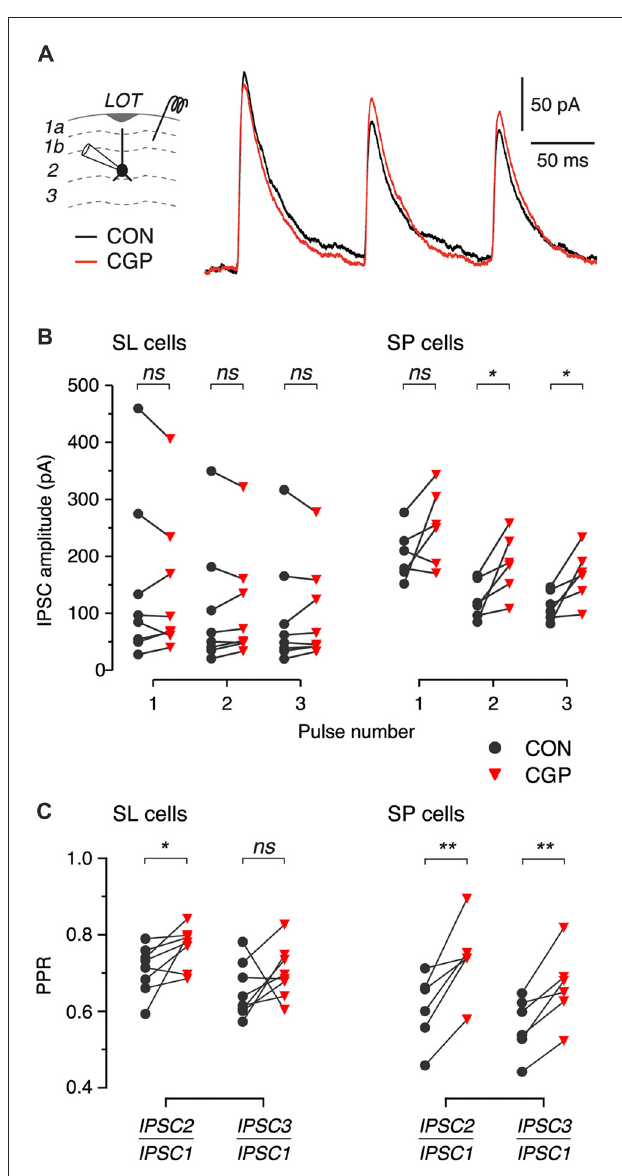
FIGURE 4 | Blockade of presynaptic GABA B autoreceptors increases the amplitude and PPR of IPSCs in SP cells. (A) Typical IPSCs recorded in response to 3-pulse train stimulation (200 ms ISI) of layer 1b during control (CON, black) and after bath application of 5 µ M CGP55845 (CGP, red). Data are from an SP cell. Each trace is an average of 8 episodes. Stimulus artifacts have been blanked. (B,C) Summary of IPSC amplitude (B) and PPR (C) before (black) and after (red) application of CGP55845 for n = 8 SL cells and n = 6 SP cells. ns , not significant; ∗ p < 0.05; ∗∗ p <